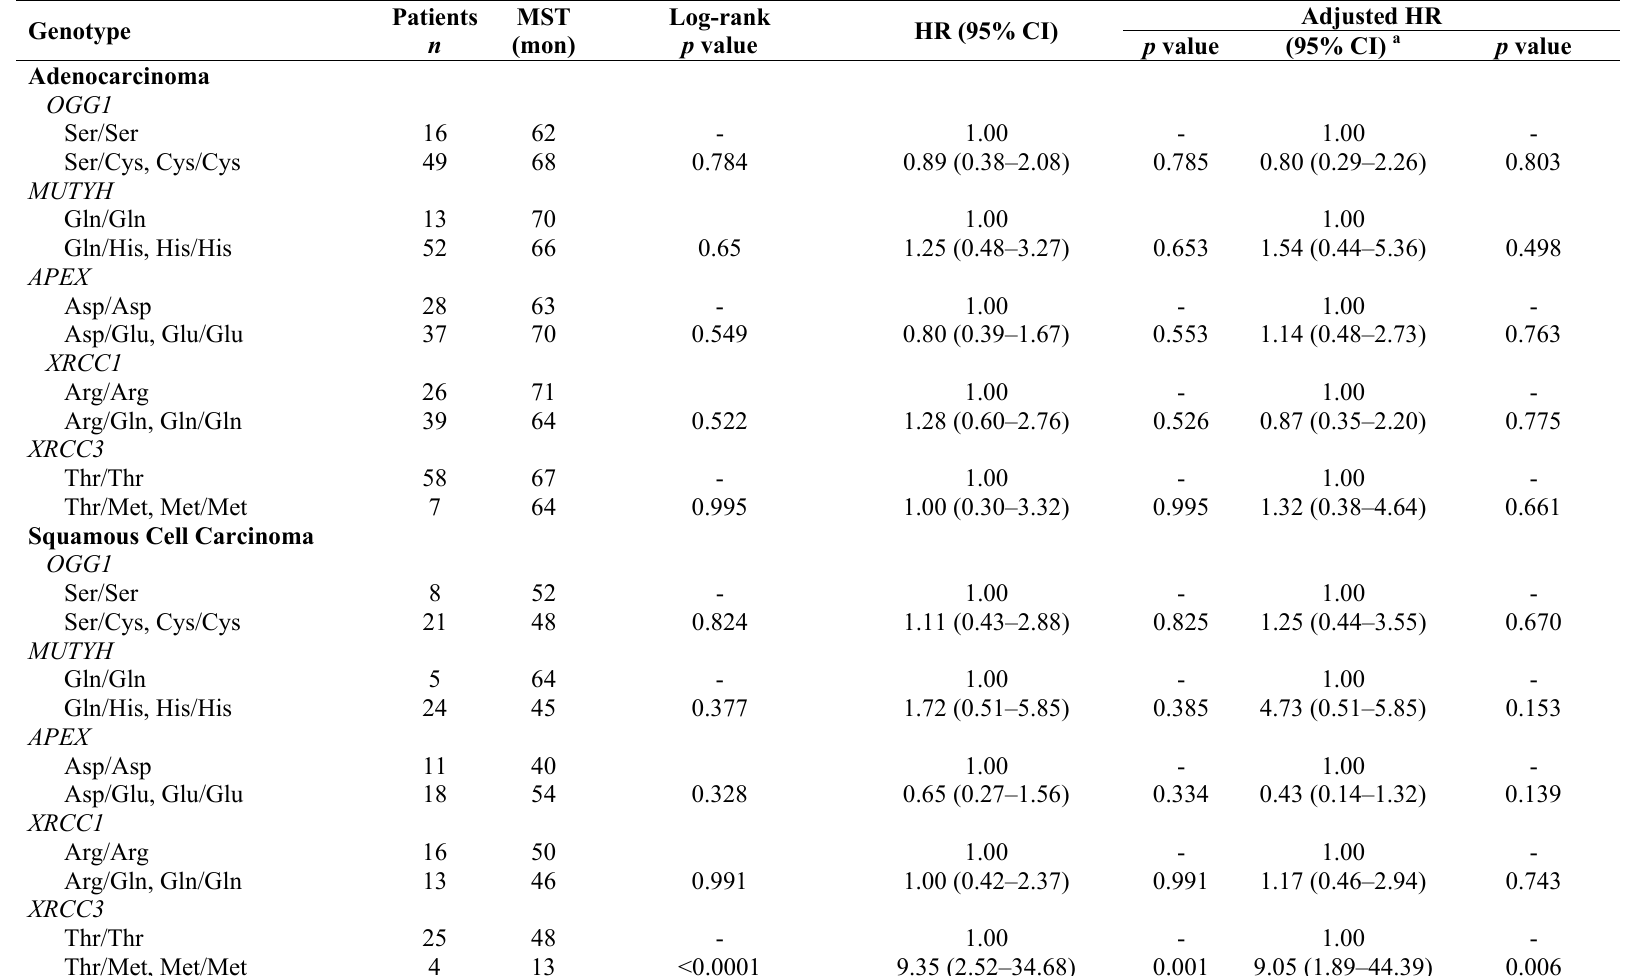
Table 3. DNA Repair Gene Polymorphisms and Patient Survival in relation to